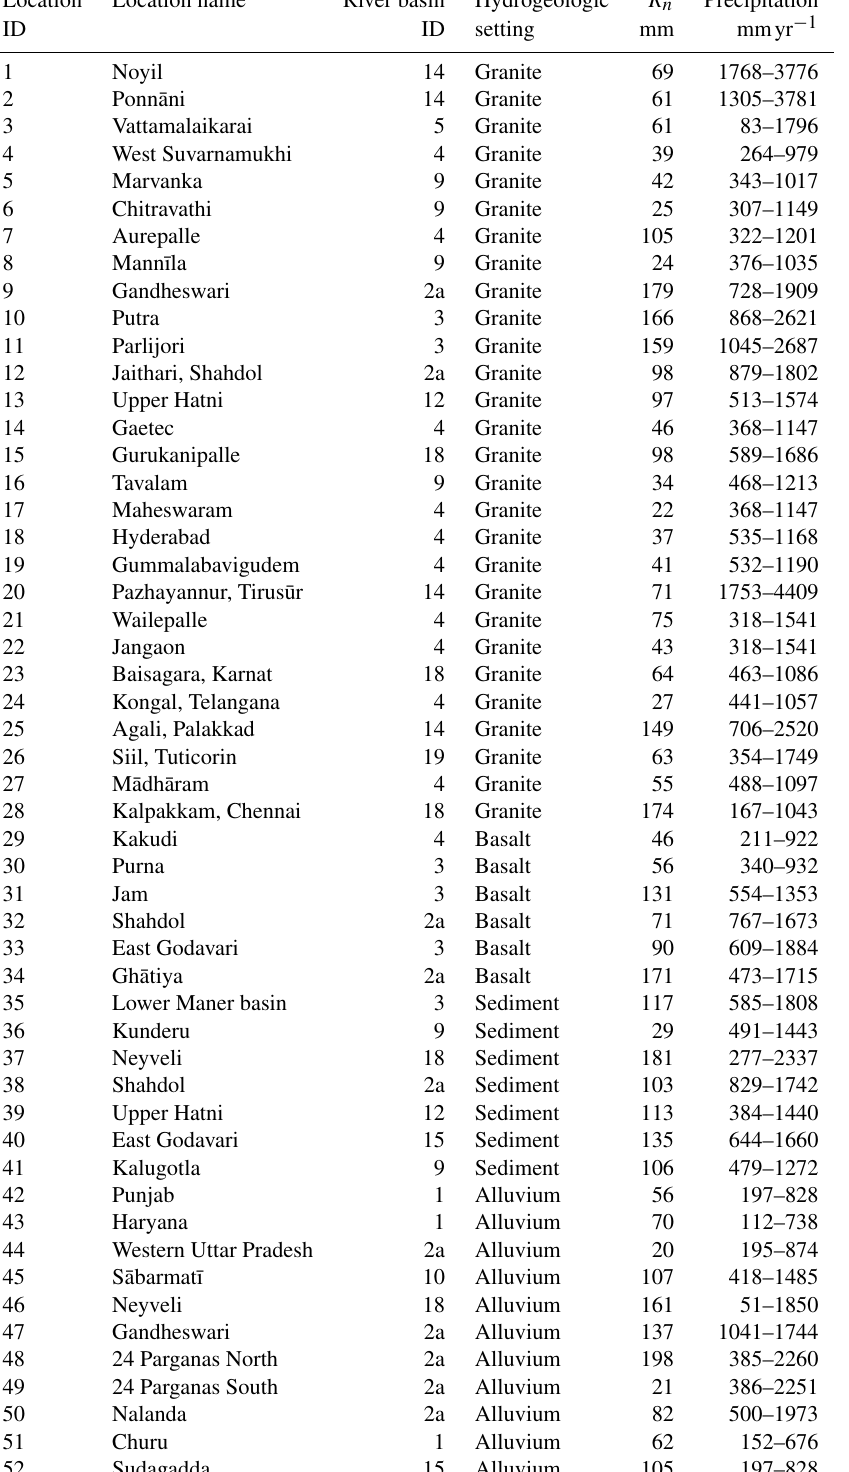
Table 2. Field-scale recharge ( R n ) estimates across 52 locations (Fig. 1), river basin ID number, hydrogeology and prevailing precipitation rates (mmyr − 1